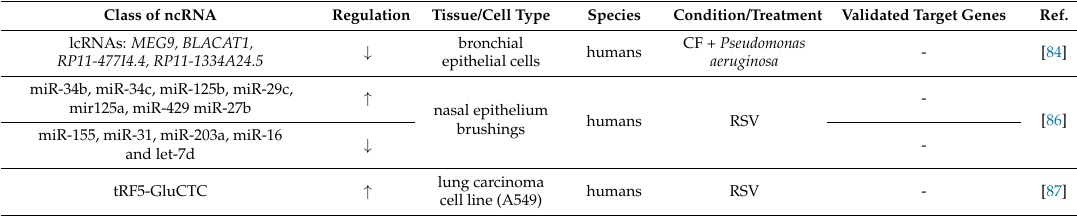
Table 3. A summary of ncRNA studies in airway cells exposed to different environmental